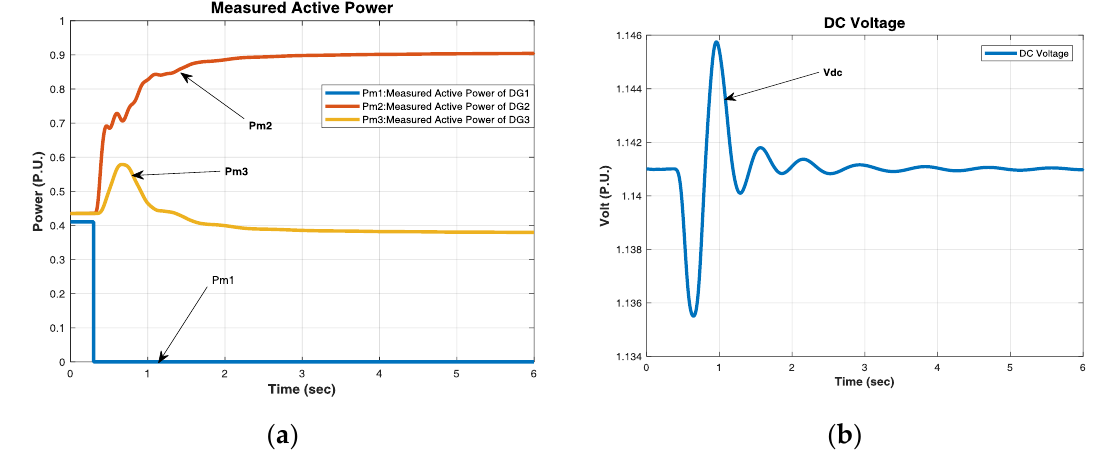
Figure 9. Microgrid response when the microgrid loses DG1.